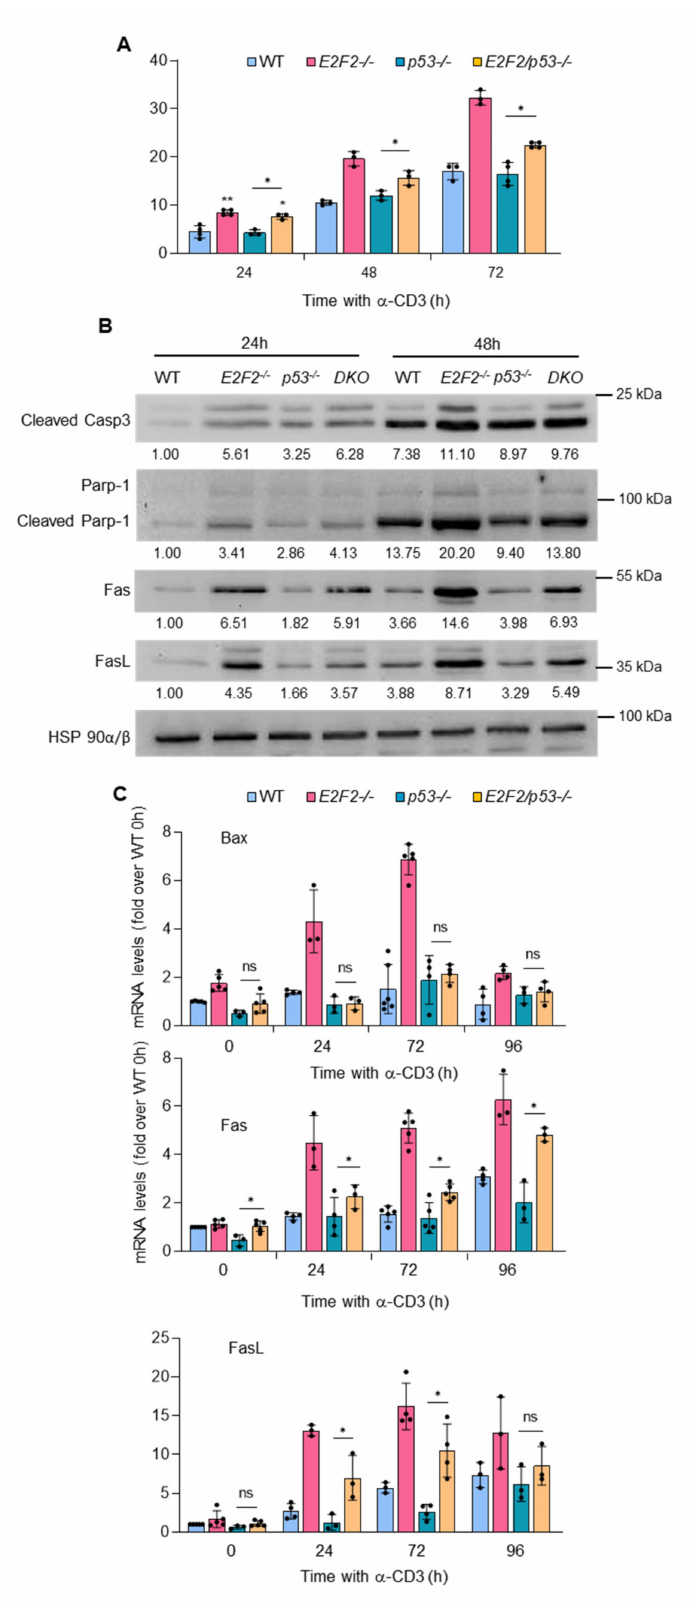
Figure 4. Evidence of p53-independent Fas/FasL upregulation and induction of apoptosis in E2f2 − / − T lymphocytes: ( A ) Apoptotic death in TCR-stimulated T cells derived from lymph nodes of WT, E2f2 − / − , p53 − / − and E2f2 − / − / p53 − / − mice, assessed by Annexin V-FITC and PI staining